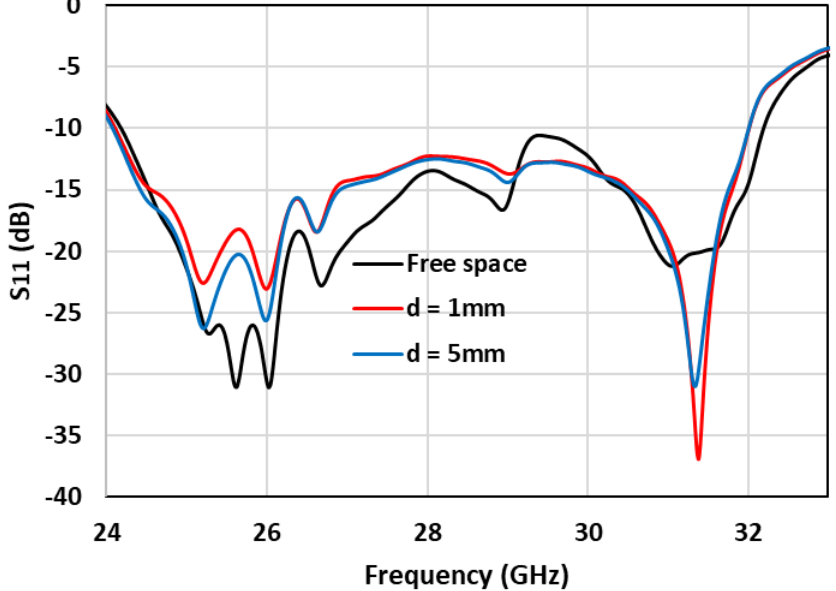
Figure 11. Reflection coefficient of a DRA array in free space and placed next to a phantom.